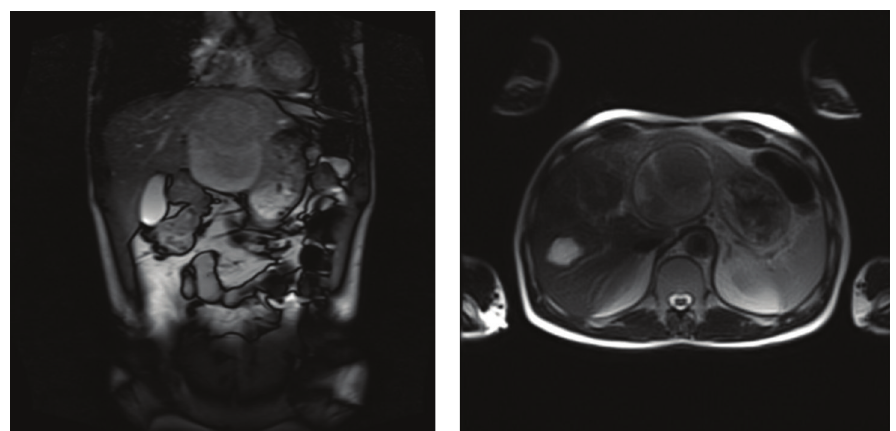
Figure 1: Magnetic resonance imaging sections.